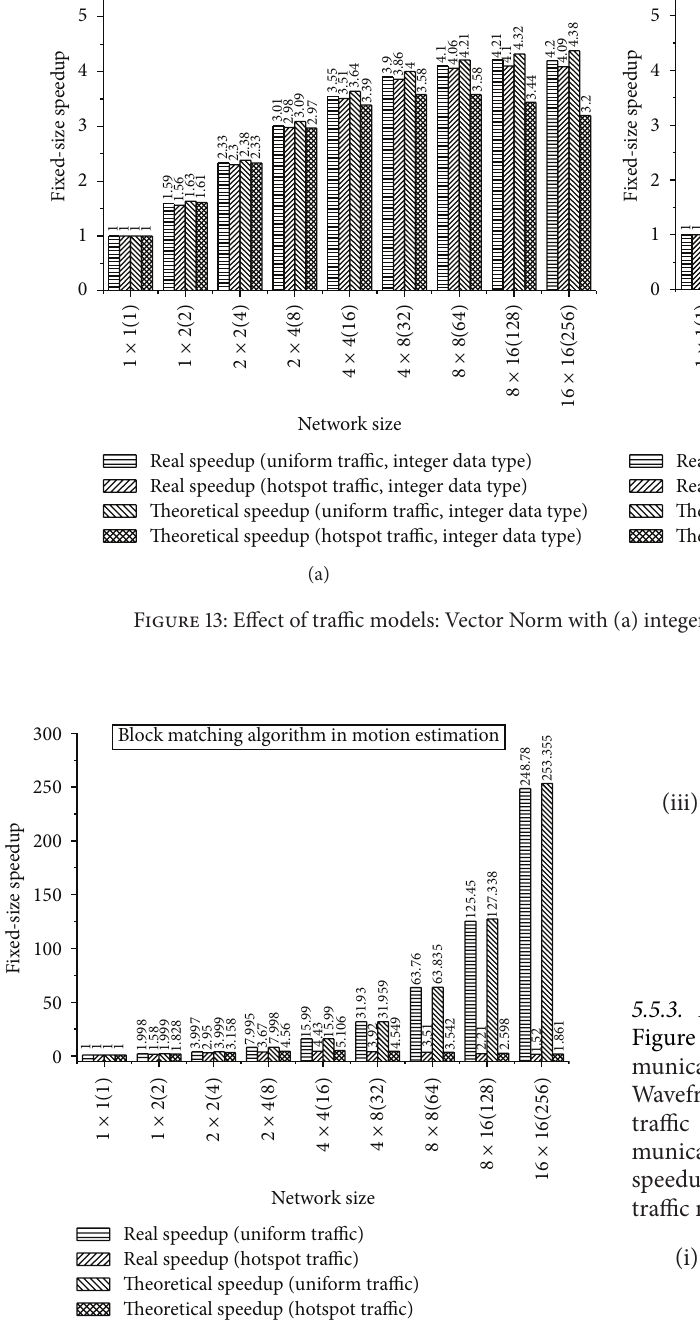
Figure 14: Effect of traffic models: Block Matching Algorithm in Motion